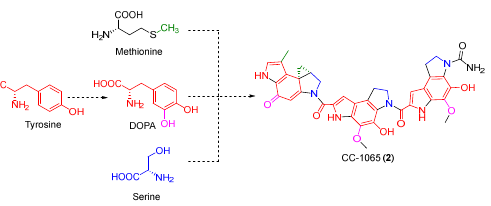
Figure 3. Isotopic labelling patterns with serine, methionine, and tyrosine.